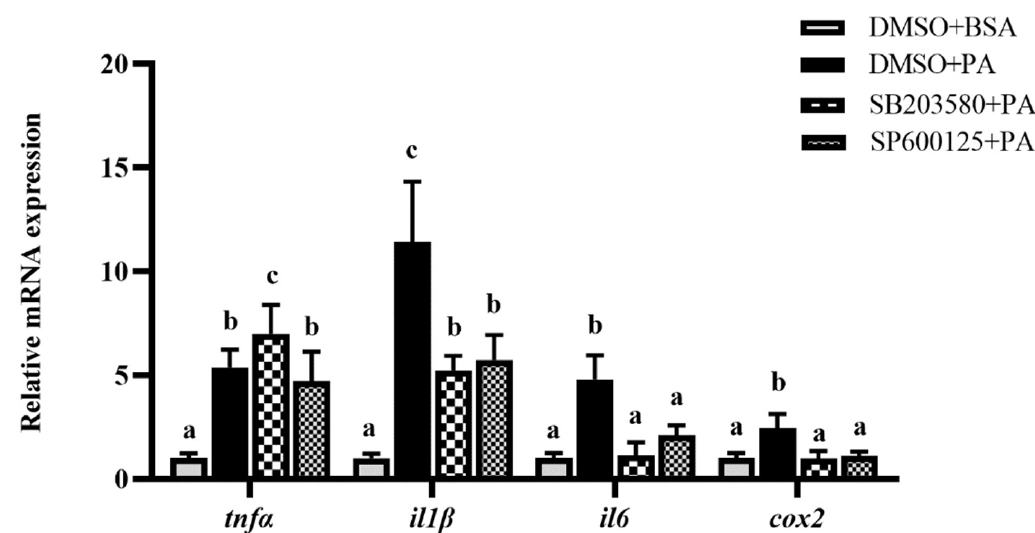
Figure 4. Effects of p38 (SB203580) and JNK (SP600125) inhibitors on the mRNA expression levels of inflammatory genes induced by PA. Data are presented as the means ± SEM ( n = 6) and are analyzed using Tukey’s test. Bars labeled with the same letters are not significantly different ( p > 0.05).